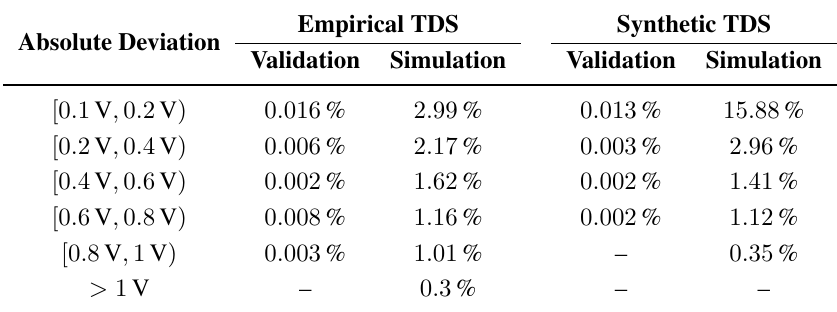
Table 2. Overview of the model error distribution for models created from an empirical training dataset (TDS) and a synthetic